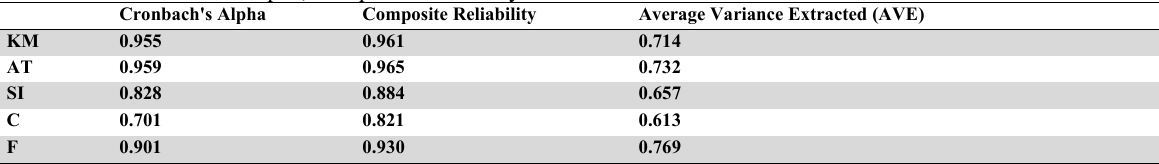
The results of Cronbach’s Alpha, Composite Reliability and AVE Cronbach's Alpha Composite Reliability Average Variance Extracted